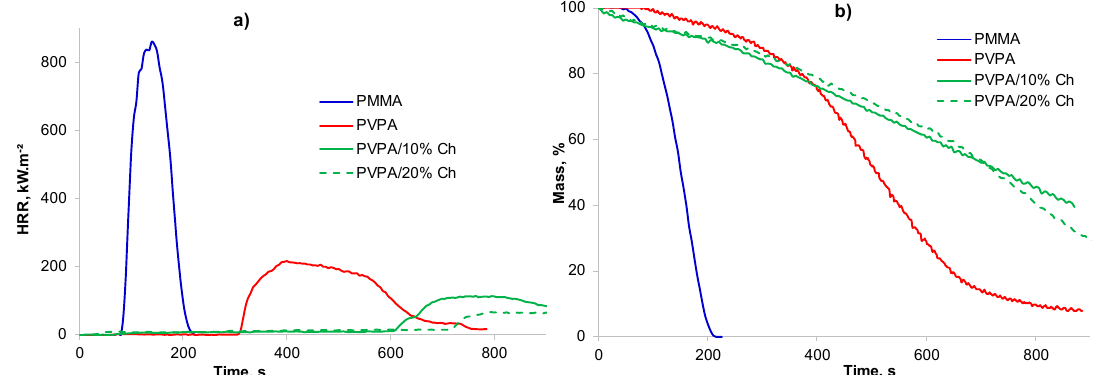
Figure 13. Plots of ( a ) heat release rate (HRR) vs. time and ( b ) mass loss vs. time for uncoated PMMA, PMMA coated with PVPA, and PMMA coated with PVPA/chitosan.